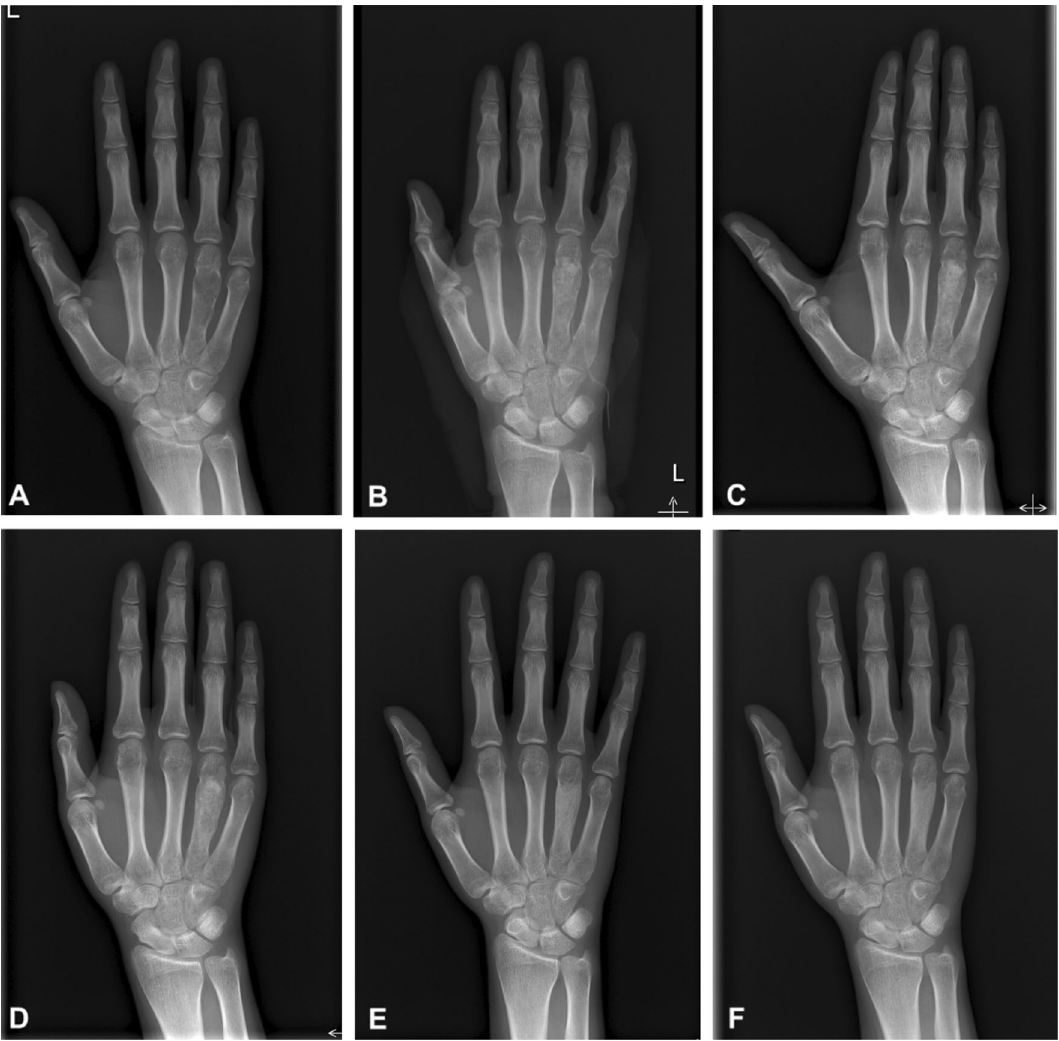
Figure 3. A 18-year-old male with enchondroma of giant form in the fourth metacarpus of the Lt. hand. Simple radiographs taken before surgery ( A ), immediately ( B ), 1 month ( C ), 2 months ( D ), 1 year ( E ), and 6 years ( F ) after